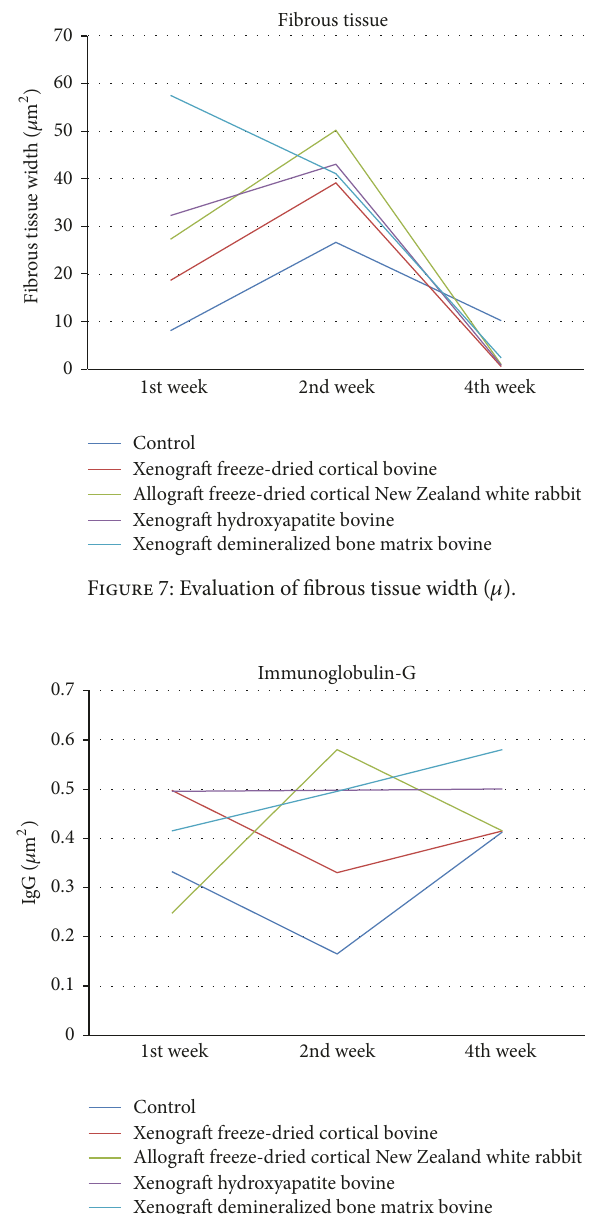
Figure 8: Evaluation of IgG/ 𝜇 m 2